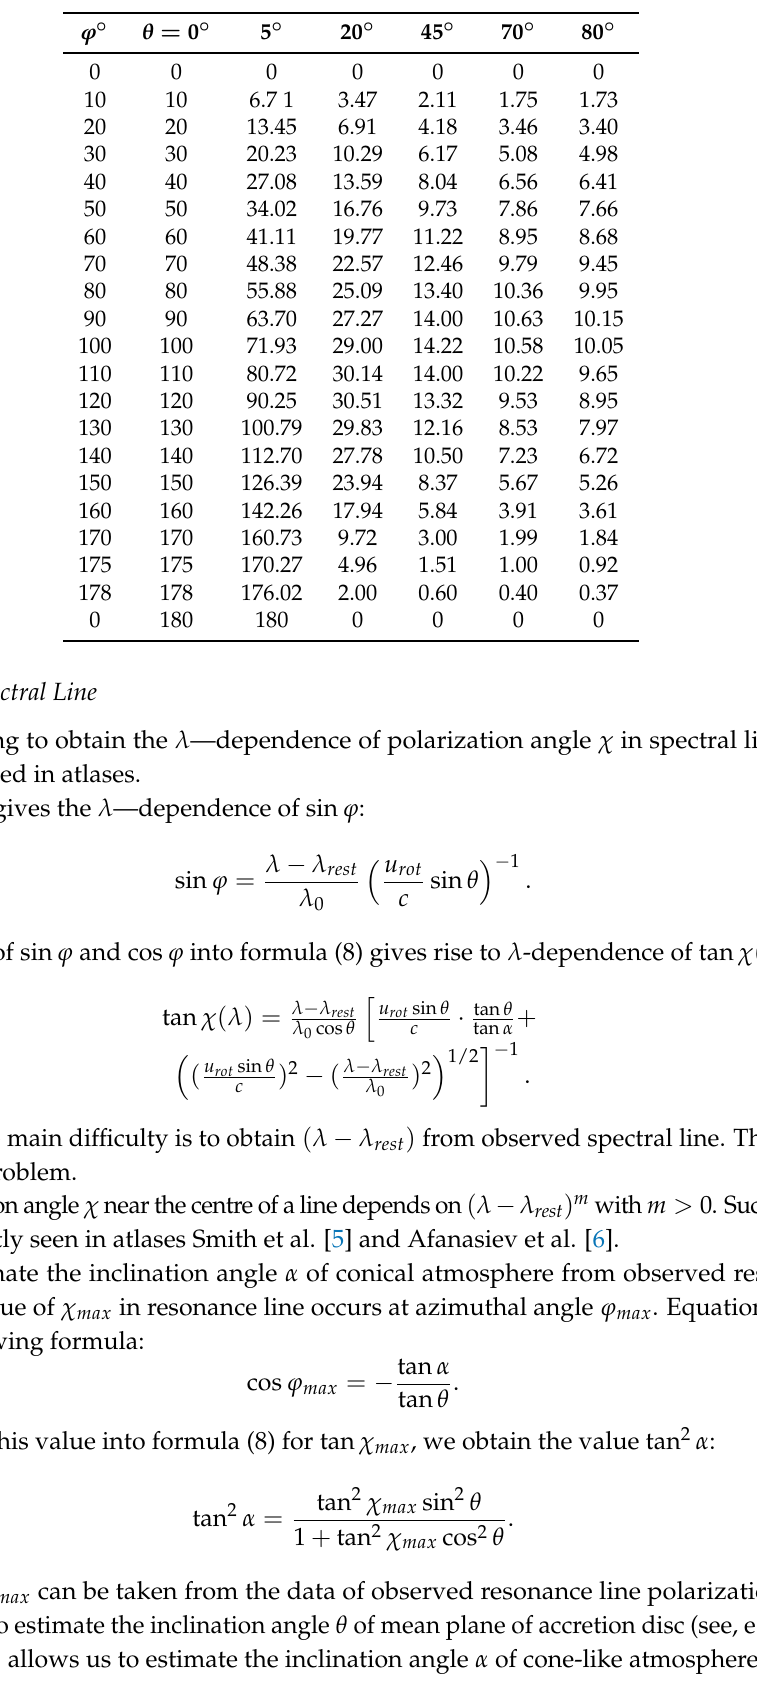
Table 1. The polarization angles χ ( ϕ ) ◦ for inclination angle α = 10 ◦